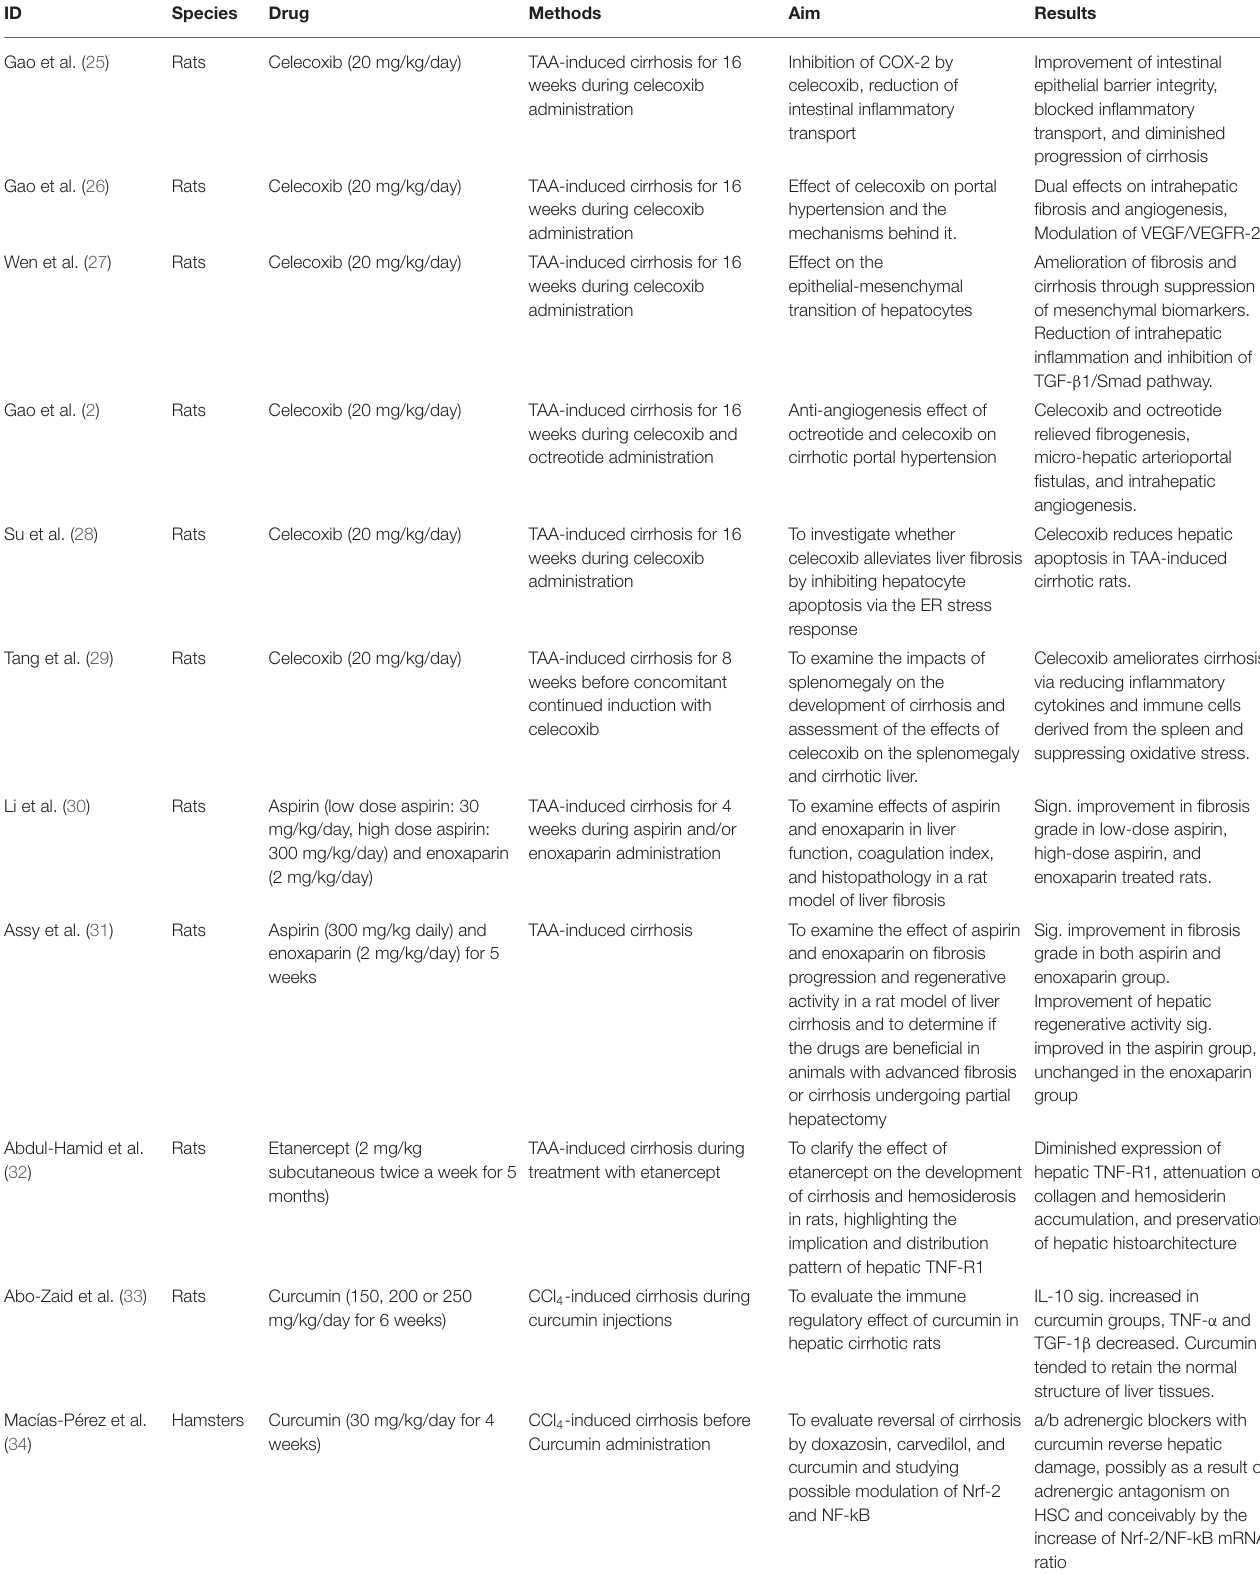
TABLE 1B | Rodent studies ( N =